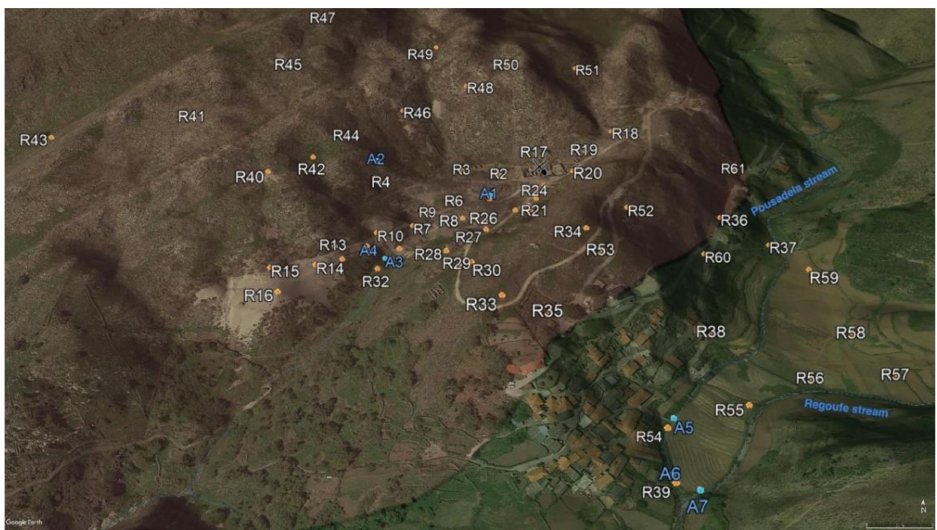
Figure 2. Location of the soil (white) and water (blue) sampling points. The black line marks the limit between the Regoufe granitic massif to the west (see-through pink colour) and the metasedimentary rocks to the east (see-through green